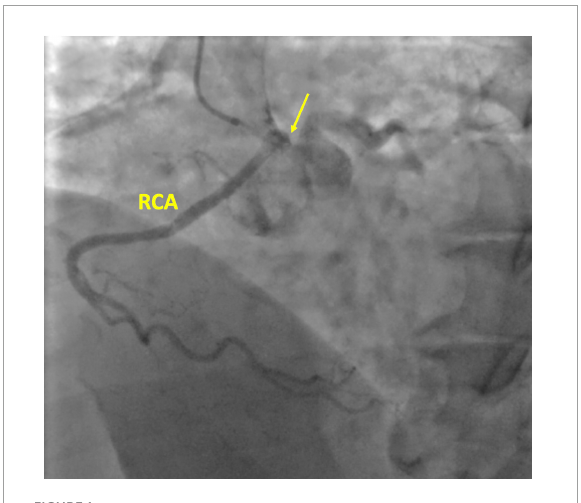
FIGURE1 Coronary angiography of the right coronary artery (RCA). The yellow arrow is pointing the right coronary ostium originating from the left coronary